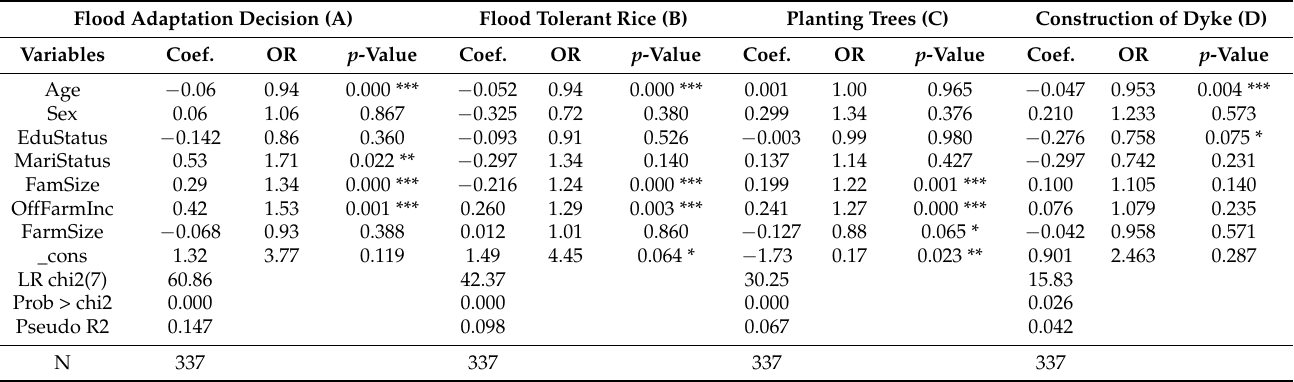
Table 5. Regression Results of the Socioeconomic Model (Long-term Adaptation